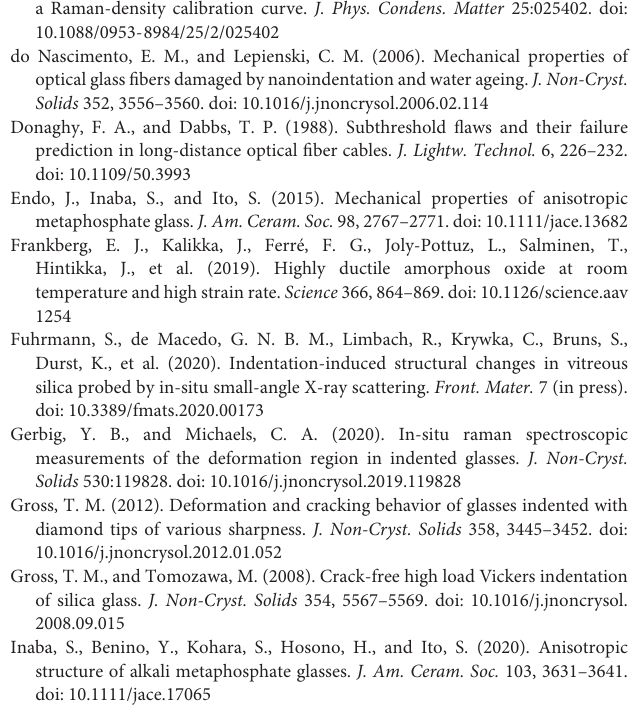
FIGURE S1 | (A) Selected load-displacement P-h curves as recorded from nanoindentation experiments on a 440 µ m silica glass fiber using a wedge-shaped tip with an opening angle of 60 ◦ and an effective length of 180 µ m. (B) Corresponding depth profiles of the representative stress σ r. Data in (B) are limited to the first pop-in event, as the incipient fracture violates the assumptions made for the calculation of the projected area by means of Equation (5). FIGURE S2 | (A) Selected load-displacement P-h curves as recorded from nanoindentation experiments on a 125 µ m silica glass fiber using a wedge-shaped tip with an opening angle of 60 ◦ and an effective length of 180 µ m. (B) Corresponding depth profiles of the representative stress σ r. Data in (B) are limited to the first pop-in event, as the incipient fracture violates the assumptions made for the calculation of the projected area by means of Equation (5). FIGURE S3 | Optical micrograph of a residual imprint on a 440 µ m silica glass fiber afterstorage for a period of six months in laboratory air under ambient conditions. The imprint was createdwith a maximum normal load of 8.98 N usinga wedge-shaped tip with an opening angle of 90 ◦ and an effective length of 215 µ m. FIGURE S4 | (A) Schematic visualization of thelateral contact area A , the enveloping cylinder surface section A s and the projected contact area A p during indentation of glass fibers with a wedge-shaped tip. (B) Calculated nominal areas A , A s and A p for indentation with a 60 ◦ wedge on a 125 µ m fiber as a function of indenter displacement h perpendicular to the fiber